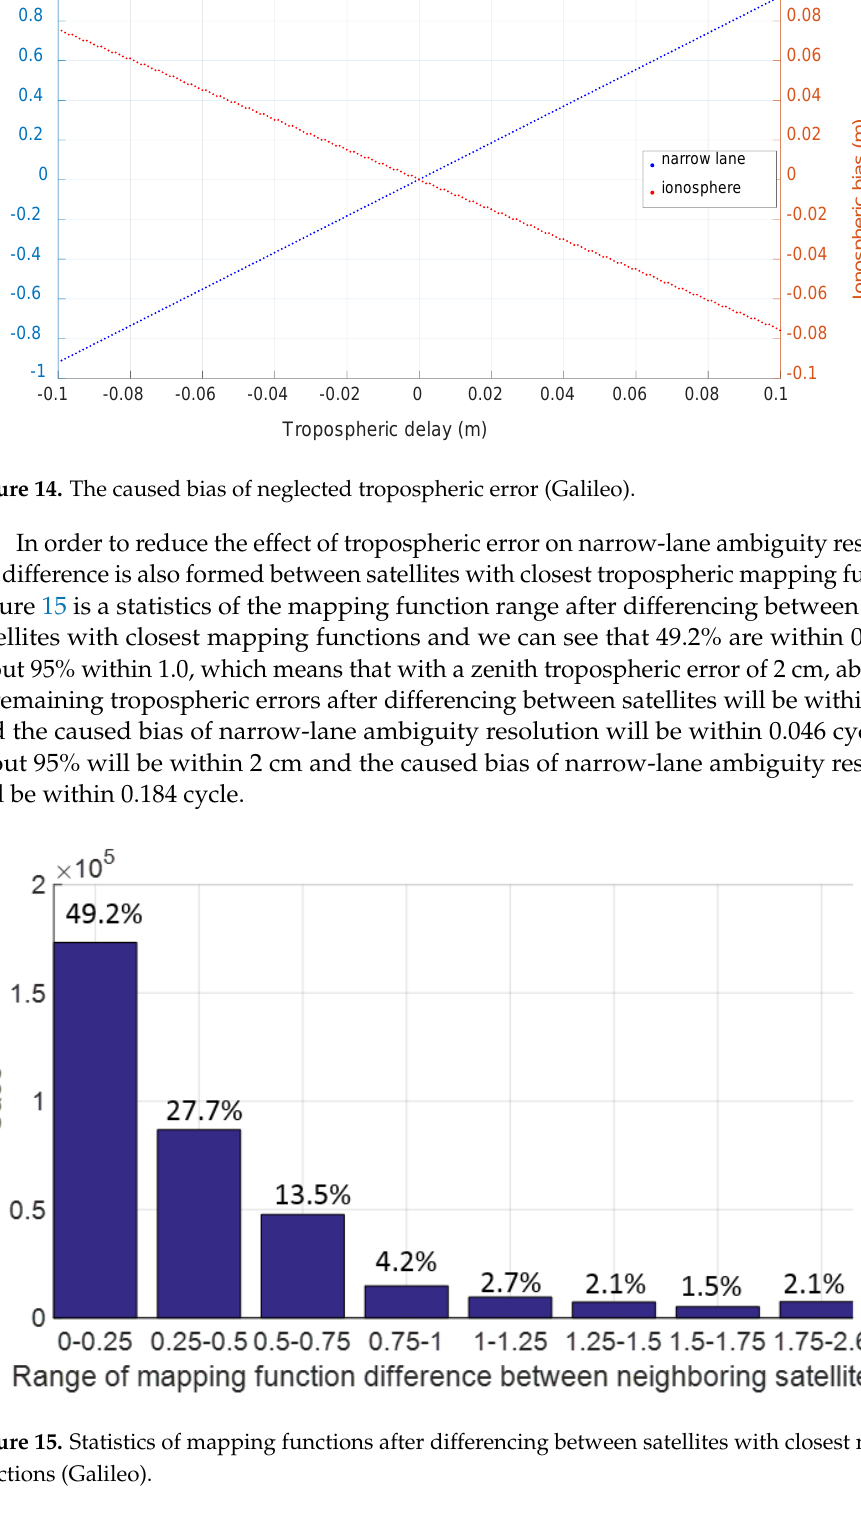
Figure 15. Statistics of mapping functions after differencing between satellites with closest mapping functions (Galileo).